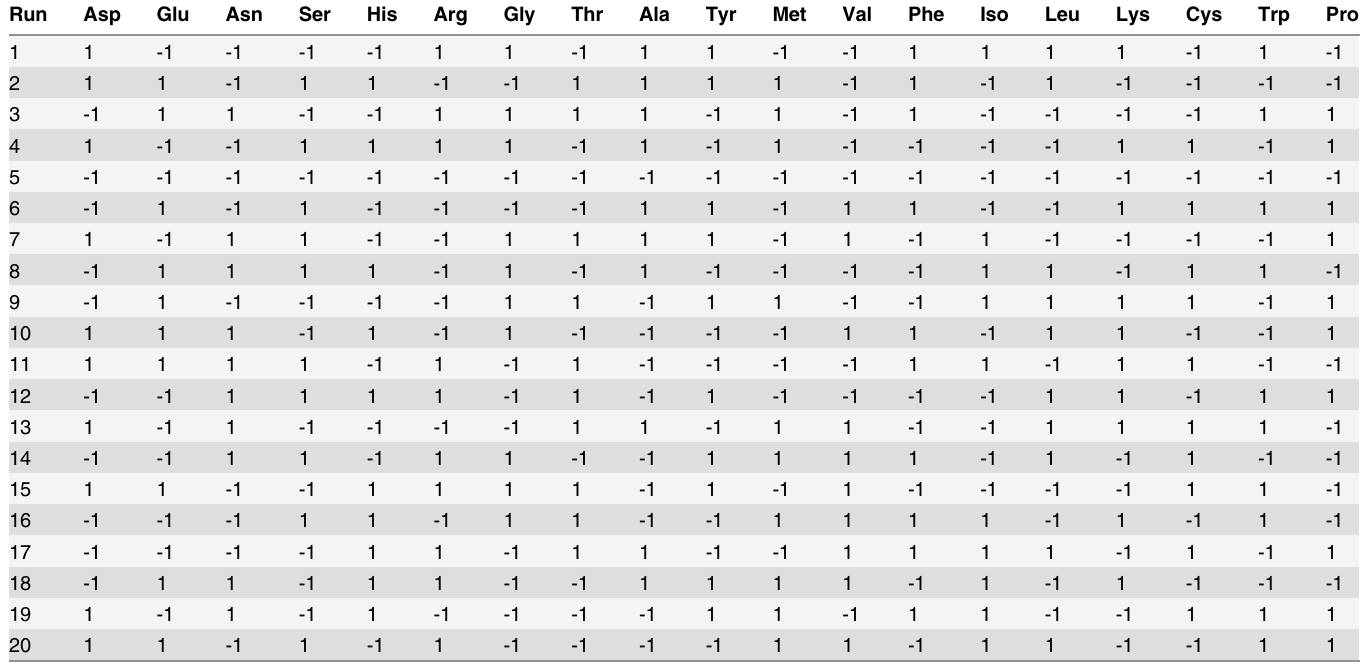
Table 1. Plackett – Burmandesign matrix, twenty runs were designed at various combinations of ‘ high ’ (1) and ‘ low ’ (-1) values of 19 different amino